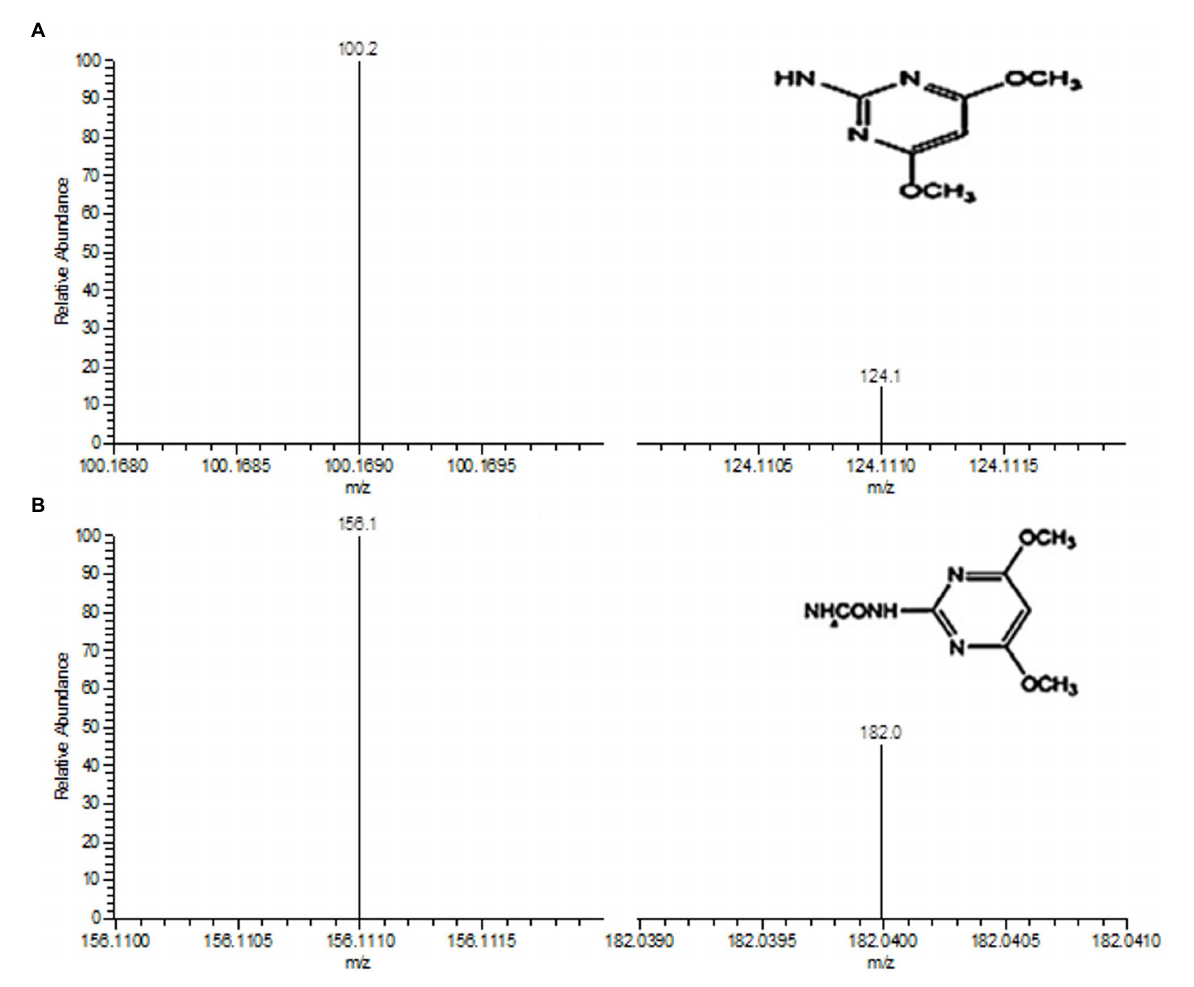
FIGURE 7 Determination of degradation metabolites 1 (A) and 2 (B) by LC–MS. The insets in A and B are the chemical structures of metabolites 1 and 2,